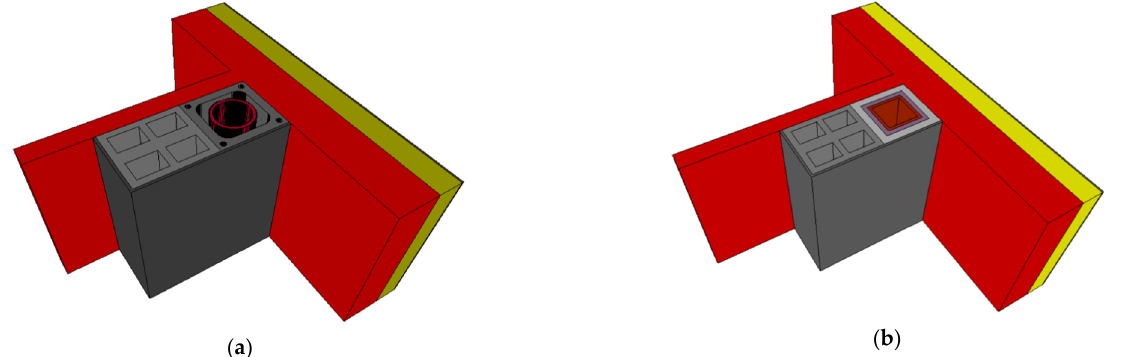
Figure 14. Actual model of the multifunctional chimney ( a ), substitute of the calculated model ( b ).